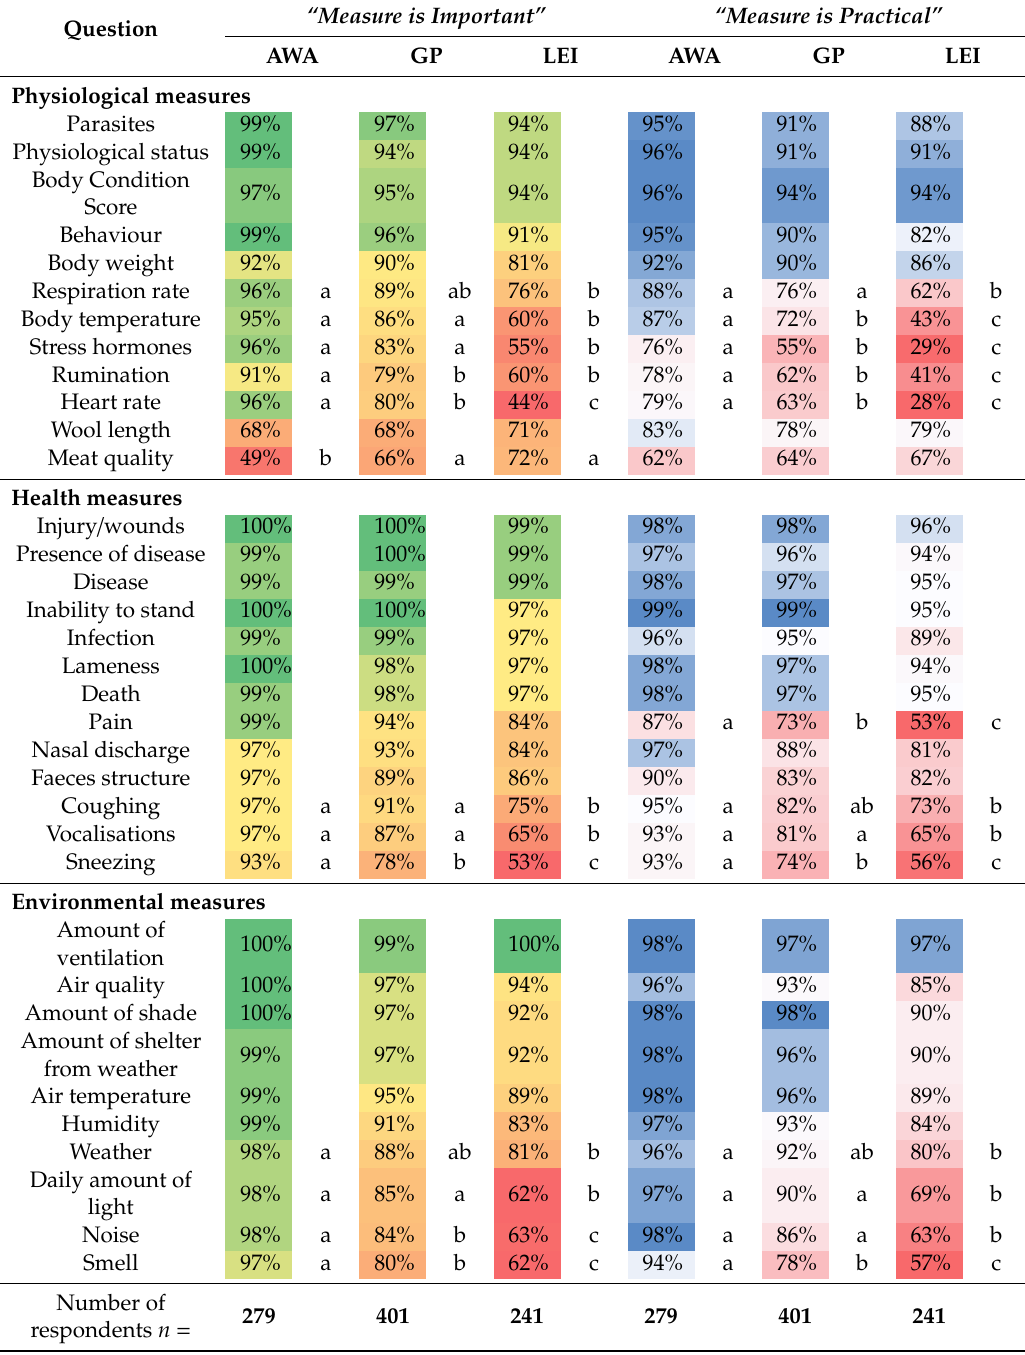
Table 1. Percentages of each of three stakeholder categories (animal welfare advocates (AWAs), general public (GP) or live export industry (LEI) workers) that indicated they believe 35 animal welfare measures are important or practical. Where there were statistically significant di ff erences in responses between stakeholder groups, the letters (a, b) link percentage values that were not significantly di ff erent from each other. Within each of the three question categories, the measures are ordered in decreasing number of respondents who identified them as important (green to red shading for importance, and blue to red shading for